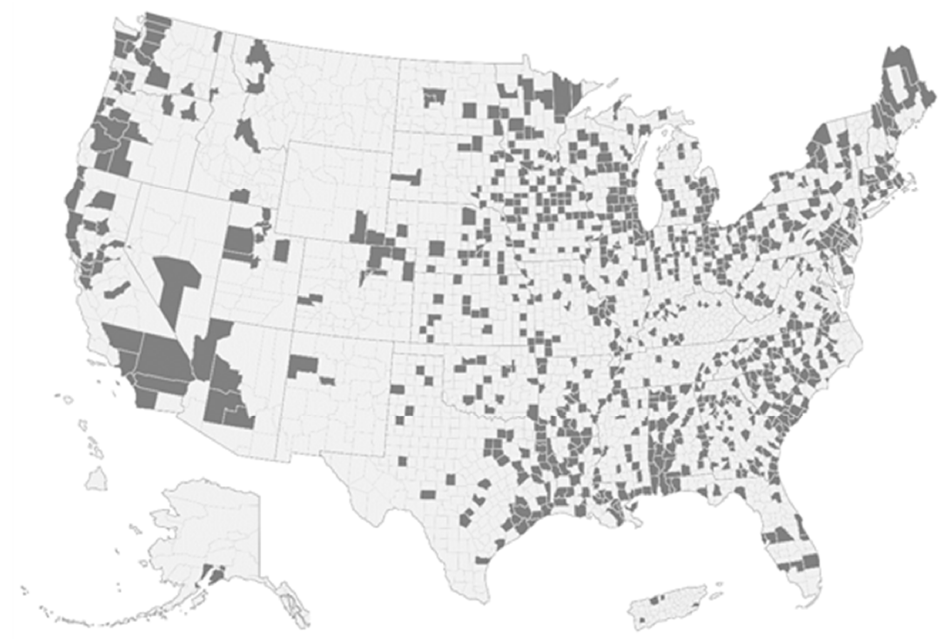
Figure 2. Counties (in grey) with facility-level emissions of formaldehyde between 2000 and 2018 (TRI).